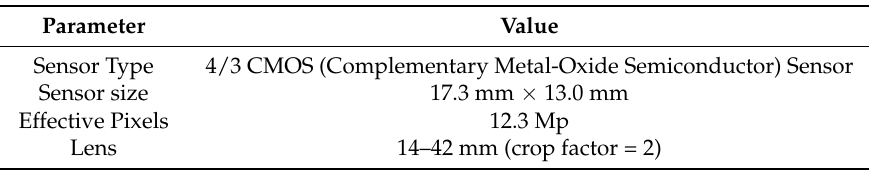
Table 1. Olympus E-PM1 camera